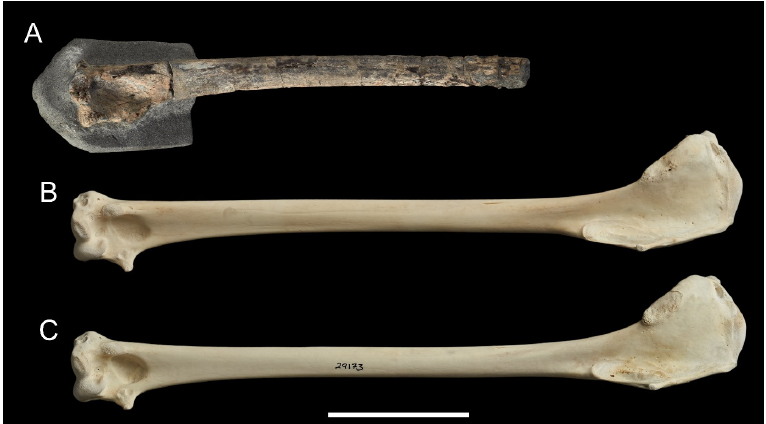
Figure 3. Left humeri of Macronectes spp. in cranial view; scale bar = 5 cm. ( A ) Macronectes tinae sp. nov., paratype NMNZ S.048870 (proximal end not preserved). ( B ) M. giganteus , NMNZ OR.029141. ( C ) M. halli , NMNZ OR.029173.